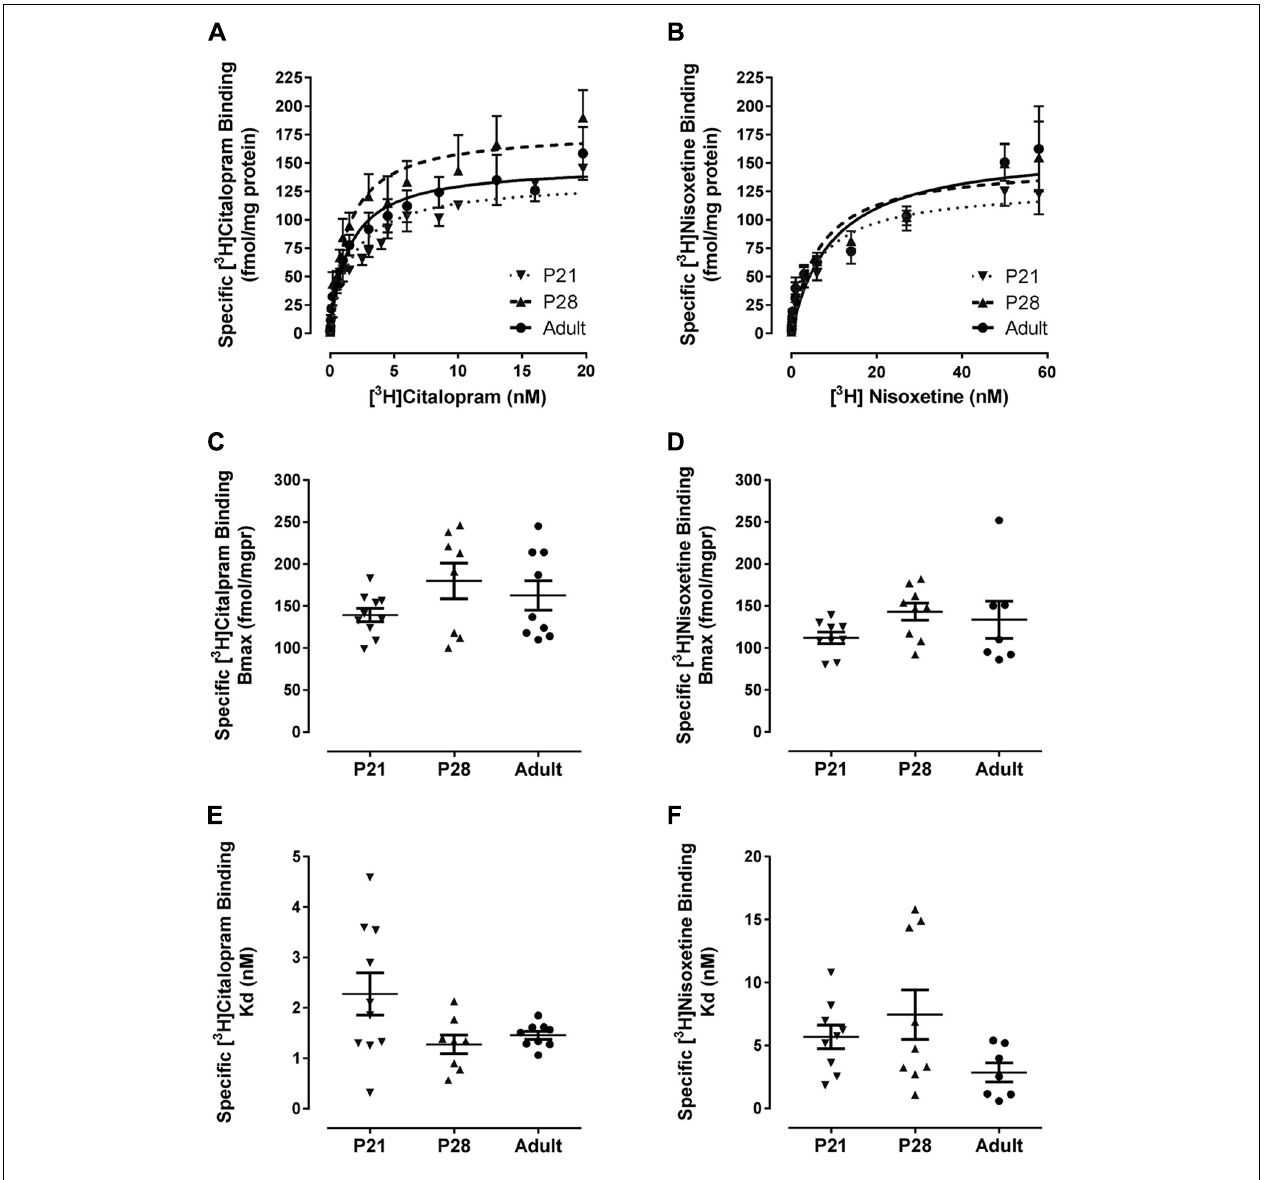
FIGURE 3 | Specific binding of [ 3 H]citalopram to SERT and [ 3 H]nisoxetine to NET in hippocampal membrane homogenates from male P21( (cid:2) ) P28 ( (cid:3) ) and adult ( • ) mice. Membrane preparations were incubated with increasing concentrations of [ 3 H]citalopram